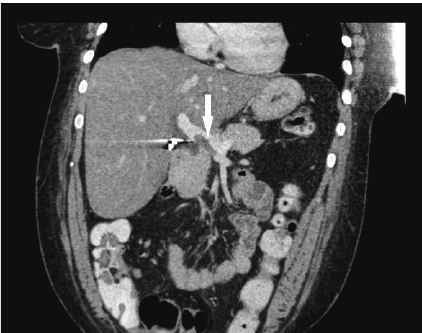
Figure 2: Computed tomography of abdomen and pelvis coronal view showing portal vein